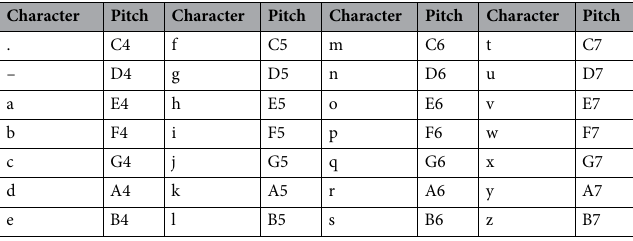
Table 5. The relationship between characters and